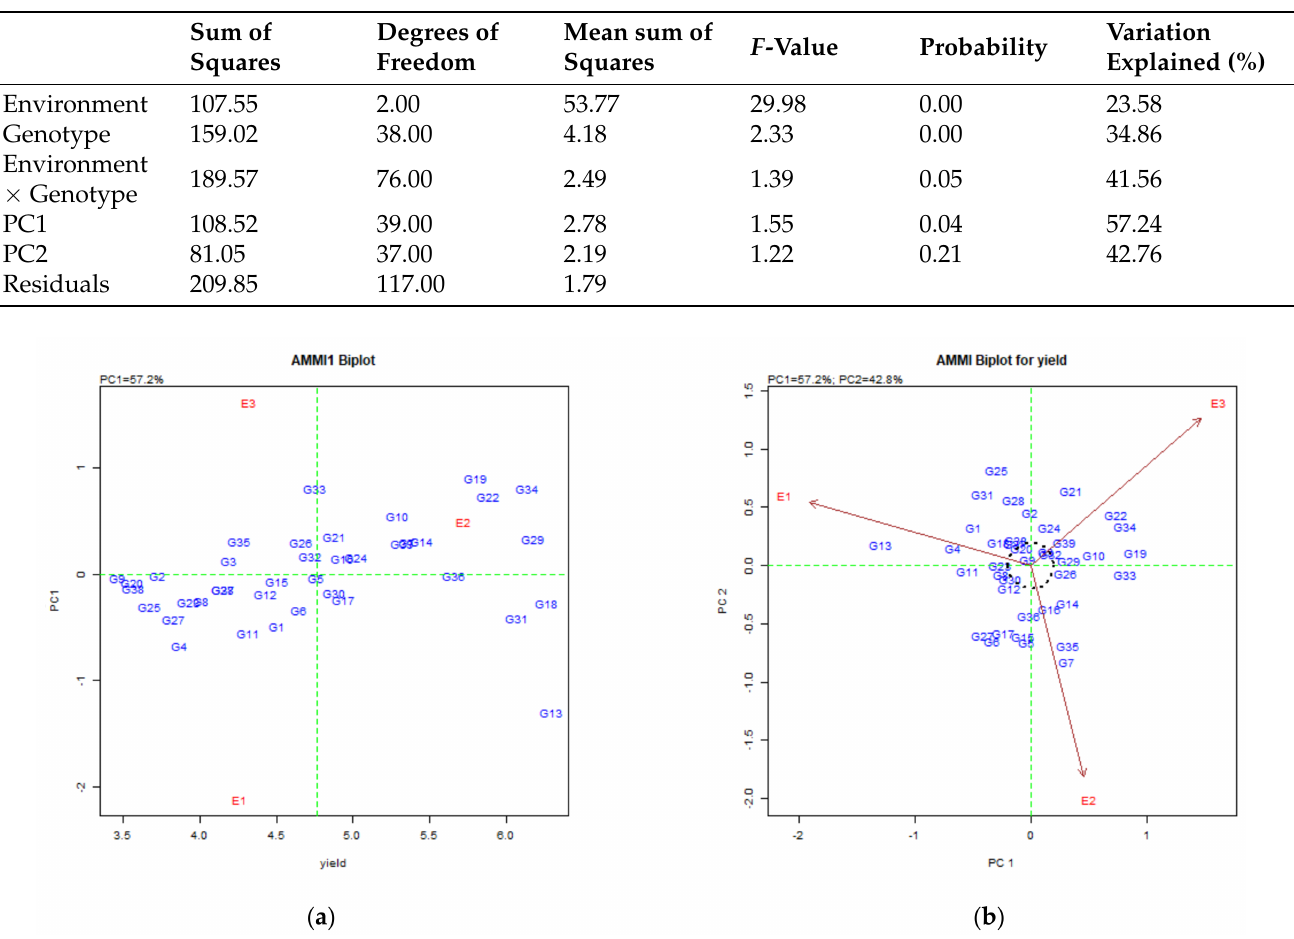
Table 4. AMMI analysis of variance for 36 blackgram mutants and their three parents across three different environments.